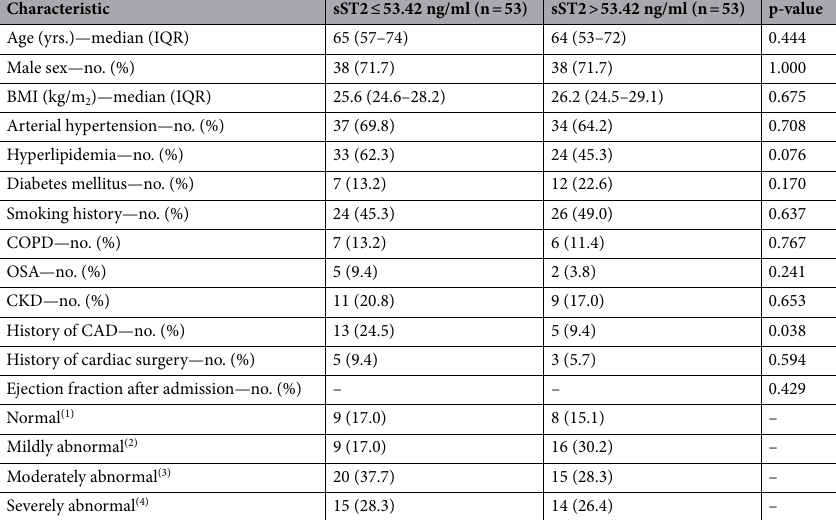
Table 1. General patient characteristics. BMI body mass index, CAD coronary artery disease, CKD chronic kidney disease, COPD chronic obstructive pulmonary disease, IQR interquartile range, no. number, OSA obstructive sleep apnea, yrs. years. Ranges of percentage for left ventricular ejection fraction: (1) “normal”: males 52–72%, females 54–74%; (2) “mildly abnormal”: males 41–51%, females 41–53%; (3) “moderately abnormal”: both sexes 30–40%; (4) “severely abnormal”: both sexes < 30%.